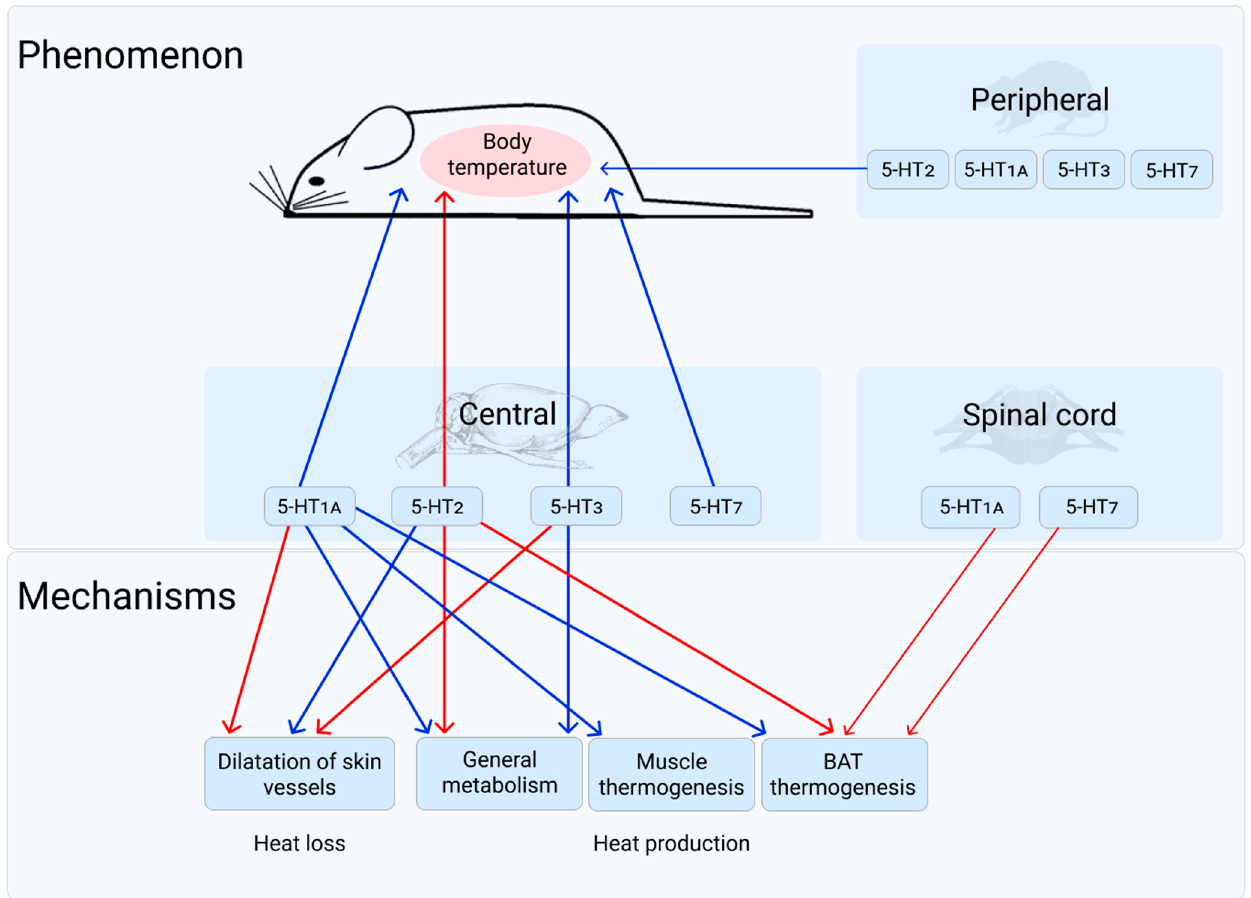
Figure 1. Phenomenon—changes in body temperature of warm blooded organism—and mechanisms of its appearance— physiological processes of heat loss and heat production that stimulation (inhibition) under 5-HT receptors activation lead to observed phenomenon. Red arrows—stimulation of physiological processes and increase of body temperature. Blue arrows—inhibition of physiological processes and decrease of body temperature.